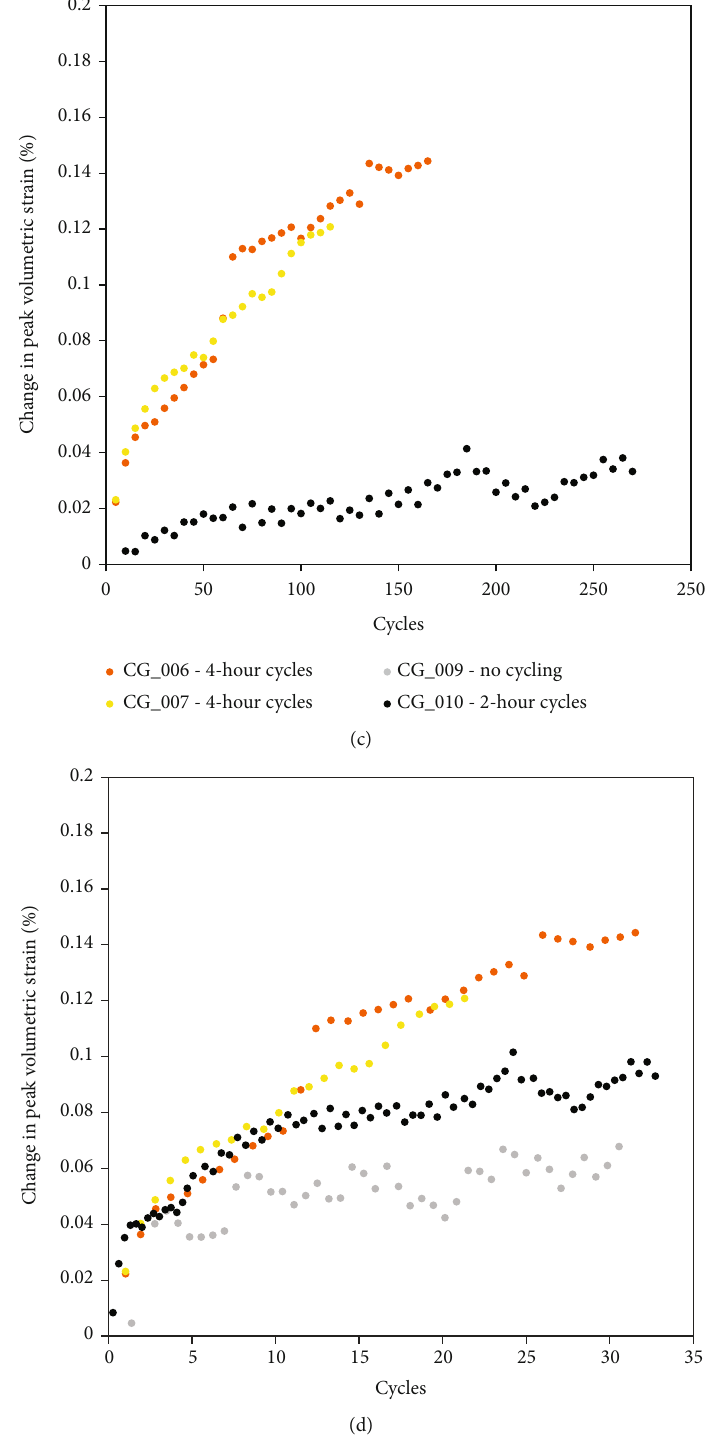
Figure 8: Average peak volumetric strain of every fi ve cycles during the tests. Tests conducted with 8-hour cycle rates are plotted against the cycle number (a) and time elapsed (b), while samples hydrostatically loaded with 4-hour cycle rates, 2-hour cycle rates, and no stress cycling are plotted against the cycle number (c) and time elapsed (d). CG_010 in (c) only shows the strain during cycling, while CG_010 in (d) shows both the initial static period ( ~ 5 days) followed by the initiation of stress